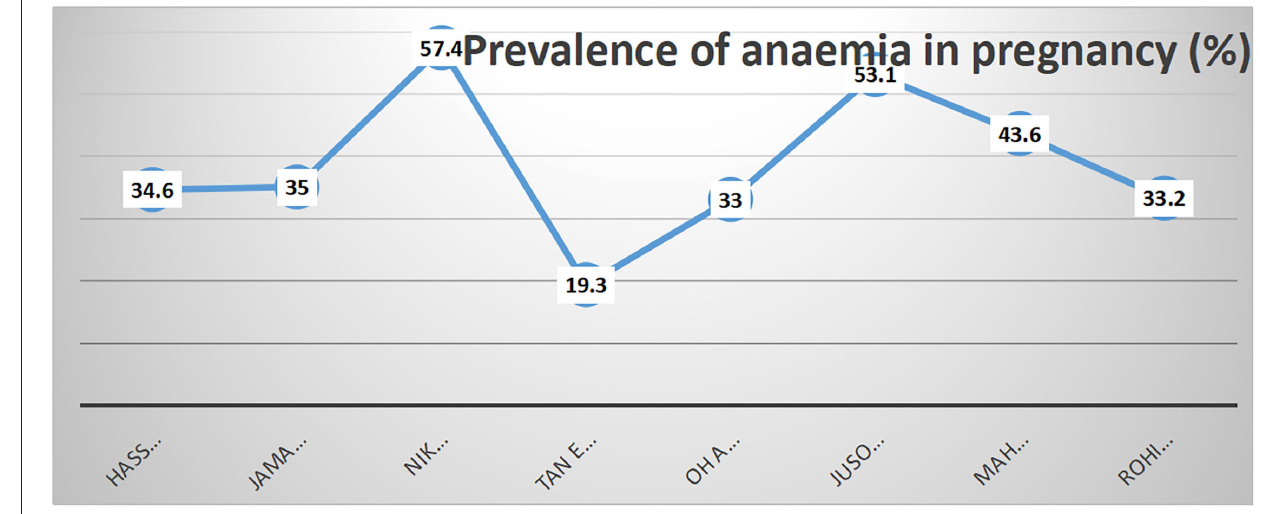
FIGURE 2 | Prevalence of anemia in included studies in sequence according to year of